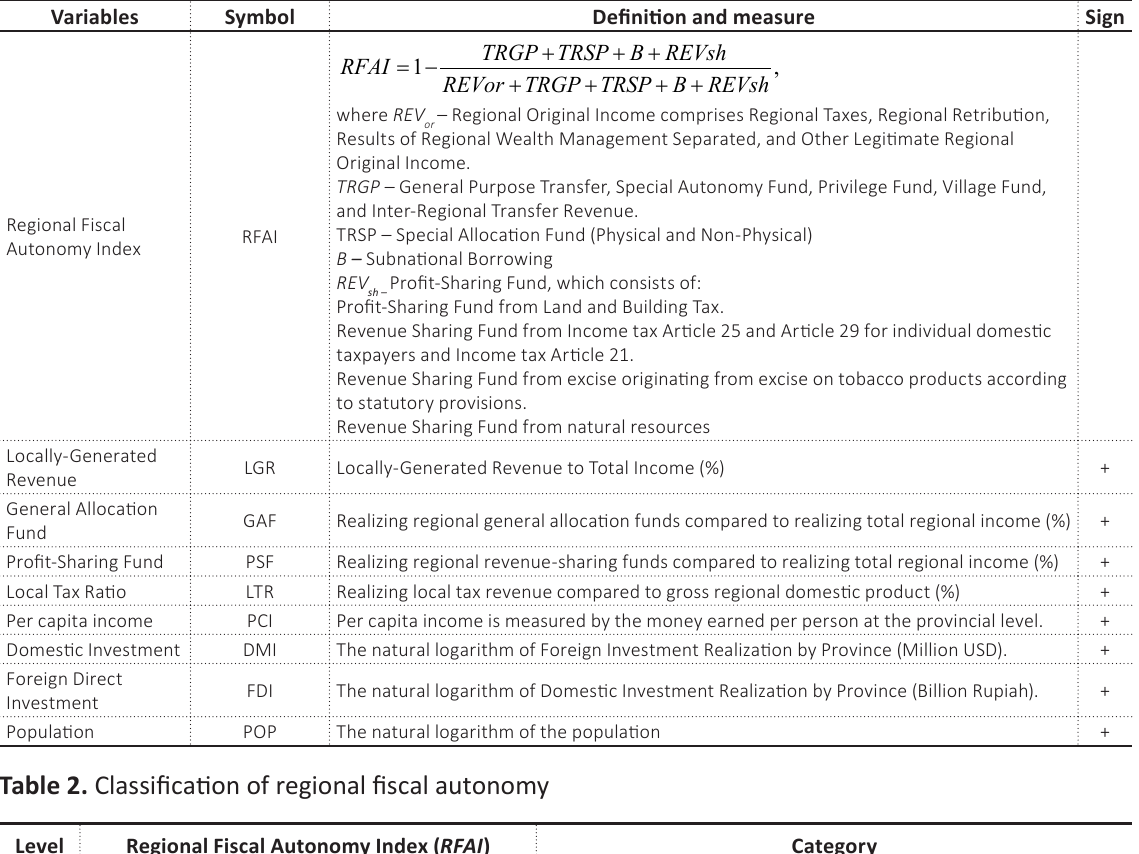
Table 1. Operational definition of variables and measurements